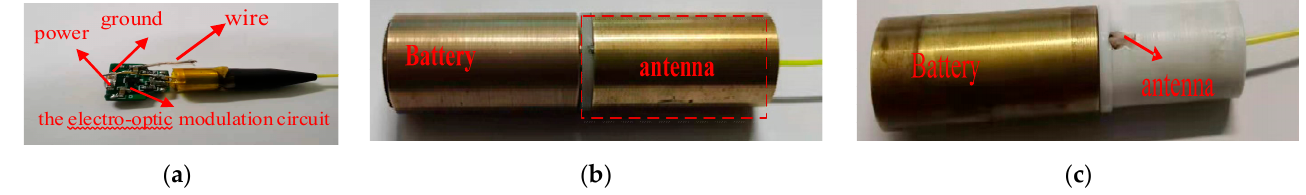
Figure 10. Photographs of the electro-optic modulation circuit ( a ), weak field sensor ( b ) and strong field sensor ( c ).